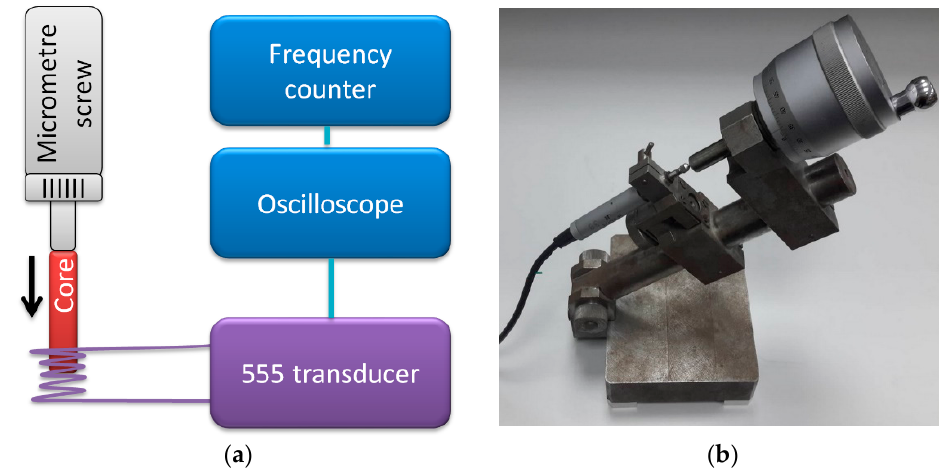
Figure 4. ( a ) Schematic diagram of measurement test stand for inductive displacement sensor calibration; ( b ) photograph of inductive sensor in mount with micrometer screw.